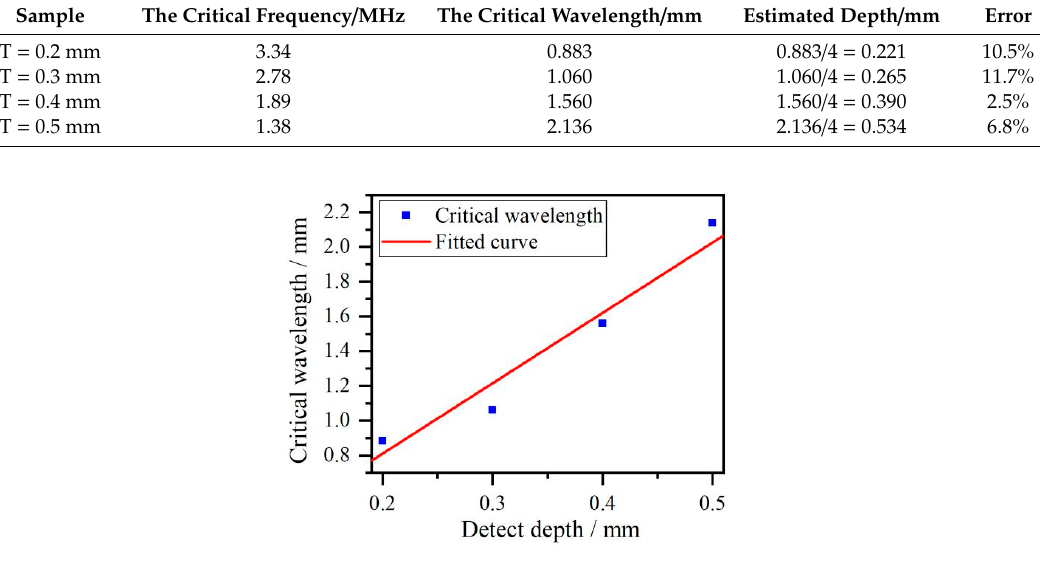
Figure 9. The critical wavelengths and cracks depth.